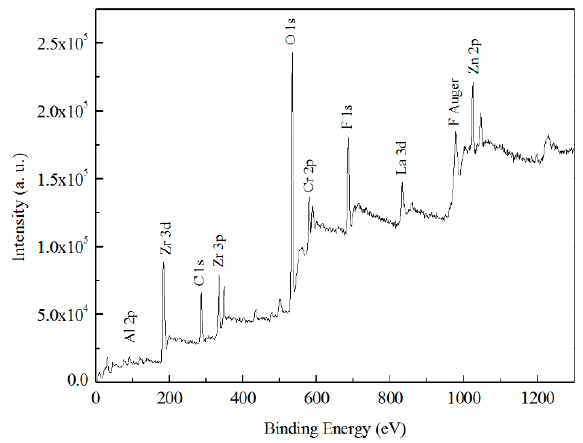
Figure 12. XPS survey scan of a selected Zn55Al specimen treated by TCP for 180 s at 40 ° C in TCP bath.